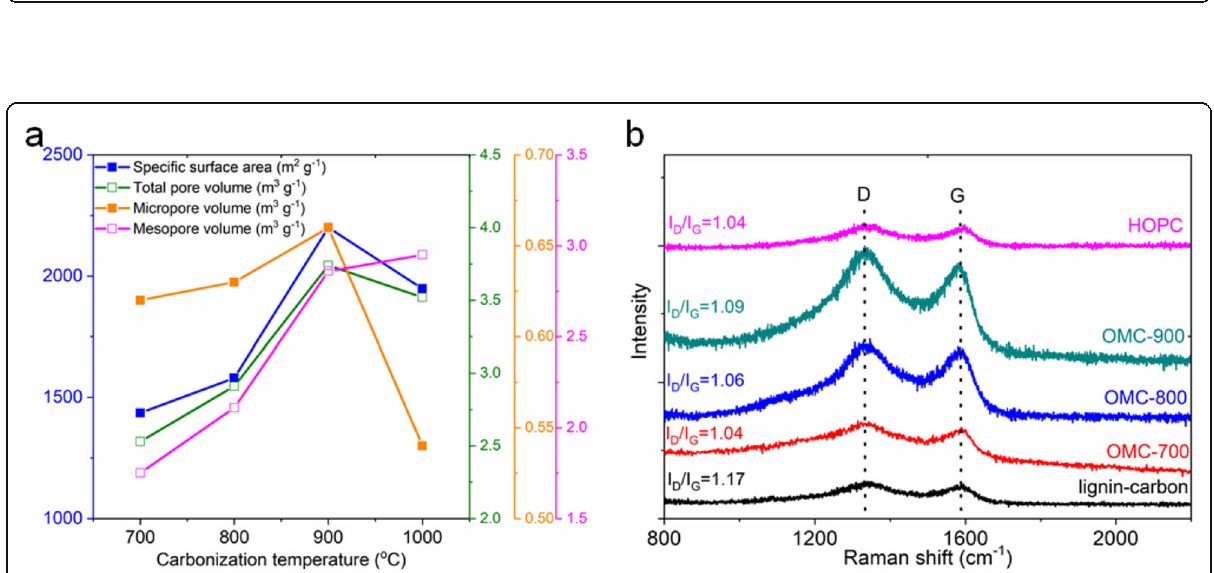
Fig. 2 Characterization of the prepared KIT-6 silica template, a Low-angle XRD pattern of KIT-6 silica template. b N 2 adsorption/desorption isotherm of KIT-6 template. c The corresponding pore size distribution for N 2 calculated using a slit pore NLDFT model. TEM images of ( d ) KIT-6 silica, the OMC carbon samples prepared at ( e ) 700 o C, ( f ) 800 o C, and ( g ) 900 o C, and the HOPC sample ( h – i ). The insert images are the corresponding Fast Fourier Transform patterns of the selected areas